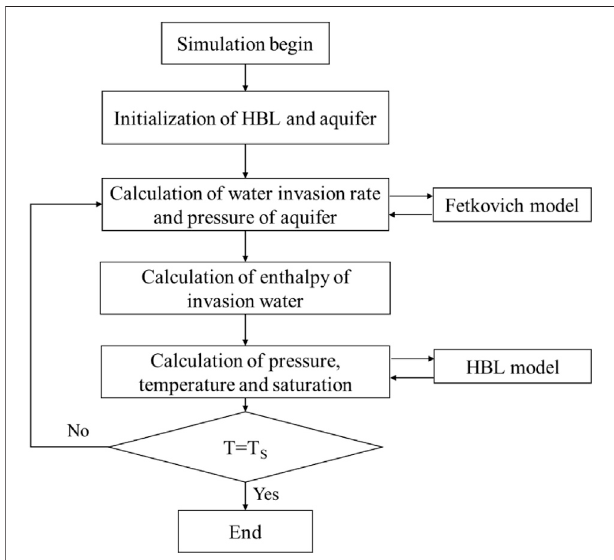
FIGURE 1 | Coupling process of the Fetkovich and HBL models.